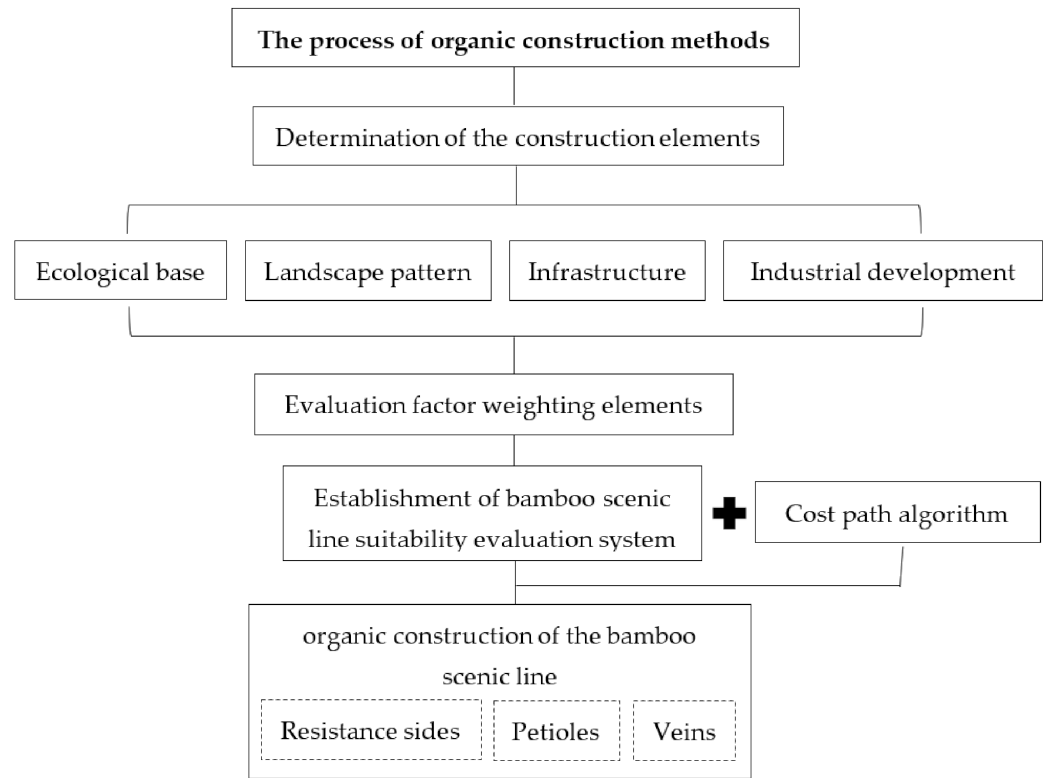
Figure 4. The chart on process of organic construction